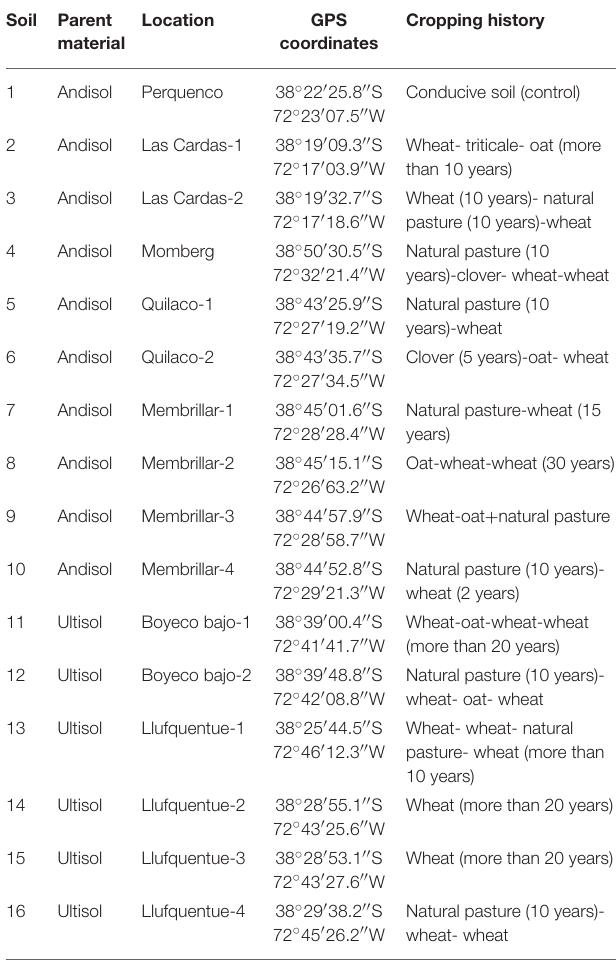
TABLE 1 | Sample locations and cropping history of soils used in this study. Soil Parent material